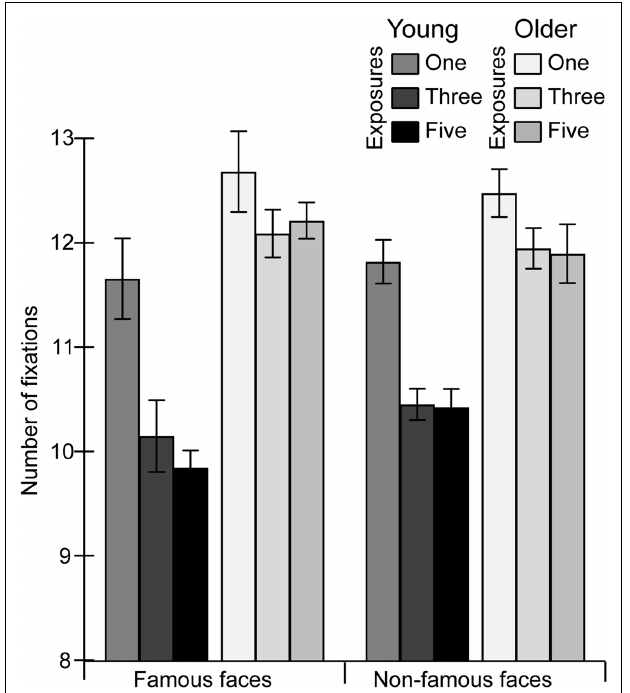
FIGURE 2 |The total number of fixations to famous and non-famous faces by young and older adults as a function of prior exposure. Error bars represent SE of the mean corrected for repeated measures specific to the within-subject contrasts (see Masson and Loftus, 2003).